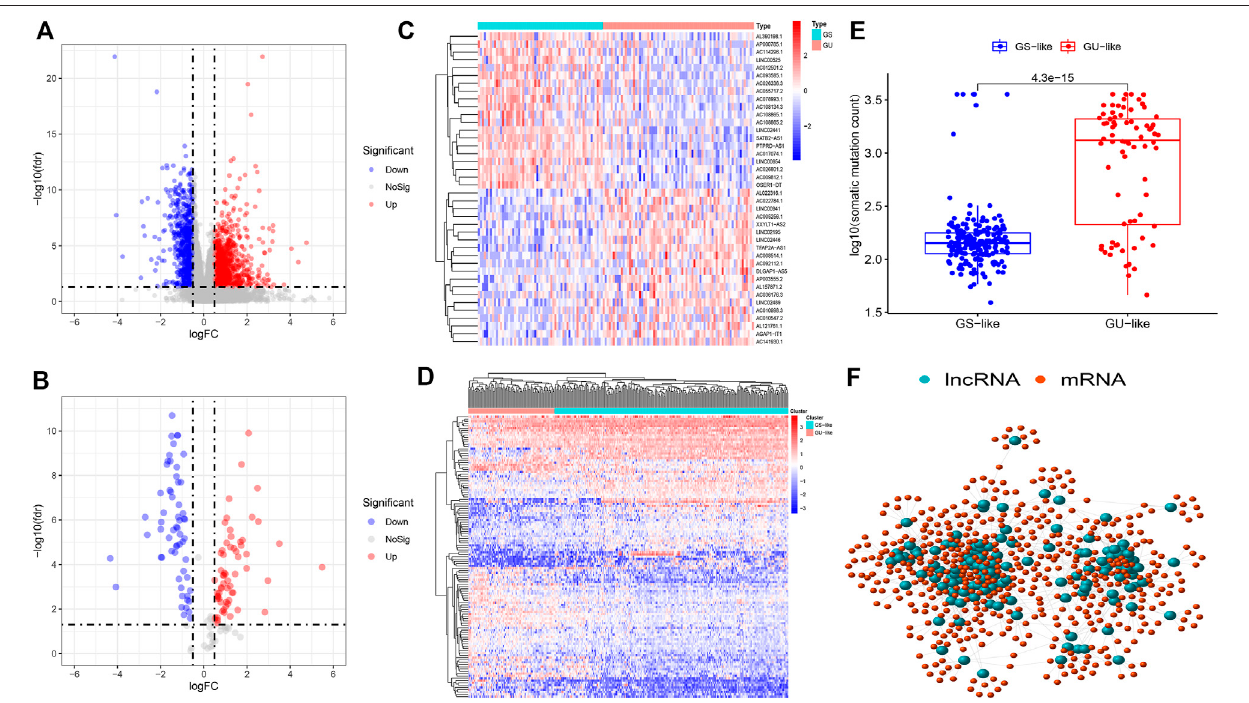
FIGURE 1 | (A) Differentially expressed genes between LCCs and RCCs. (B) Differentially expressed DGIA lncRNAs between GU group and GS group. Red and blue circles indicate high and low genes expression, respectively. (C) Heat map depicts the differentially expressed DGIA lncRNAs in TCGA patients. (D) Unsupervised clustering of TCGA patients based on the expression pattern of 128 candidate DGIA lncRNAs. (E) In boxplot, cumulative number of somatic mutations in the GU-like groupissigni fi cantlyhigher thanthatintheGS-like group (F) Co-expressionnetworkofDGIAlncRNAsandintersectionofmRNAsbasedontwomethods.Thered circles represent lncRNAs, and the blue circles represent mRNAs. LCCs and RCCs: left- and right-sided colon adenocarcinoma; DGIA lncRNAs: genomic instability- associated long non-coding RNAs; GU: genomic unstable; GS: genomic